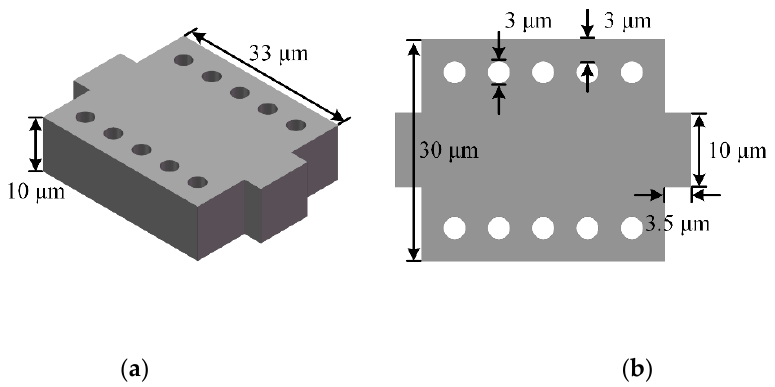
Figure 1. The structure of one-dimensional phononic crystal (PnC). ( a ) 3D schematic view of the proposed PnC configuration; ( b ) Top view of the PnC.